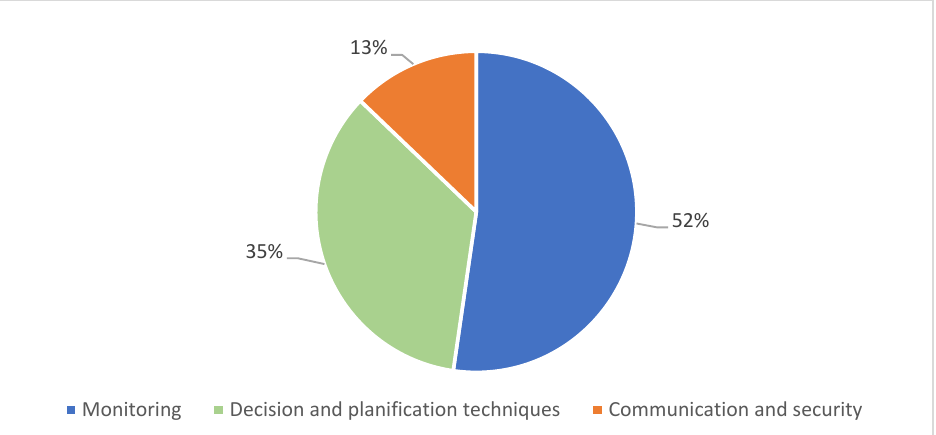
Figure 3. Summary review protocol.